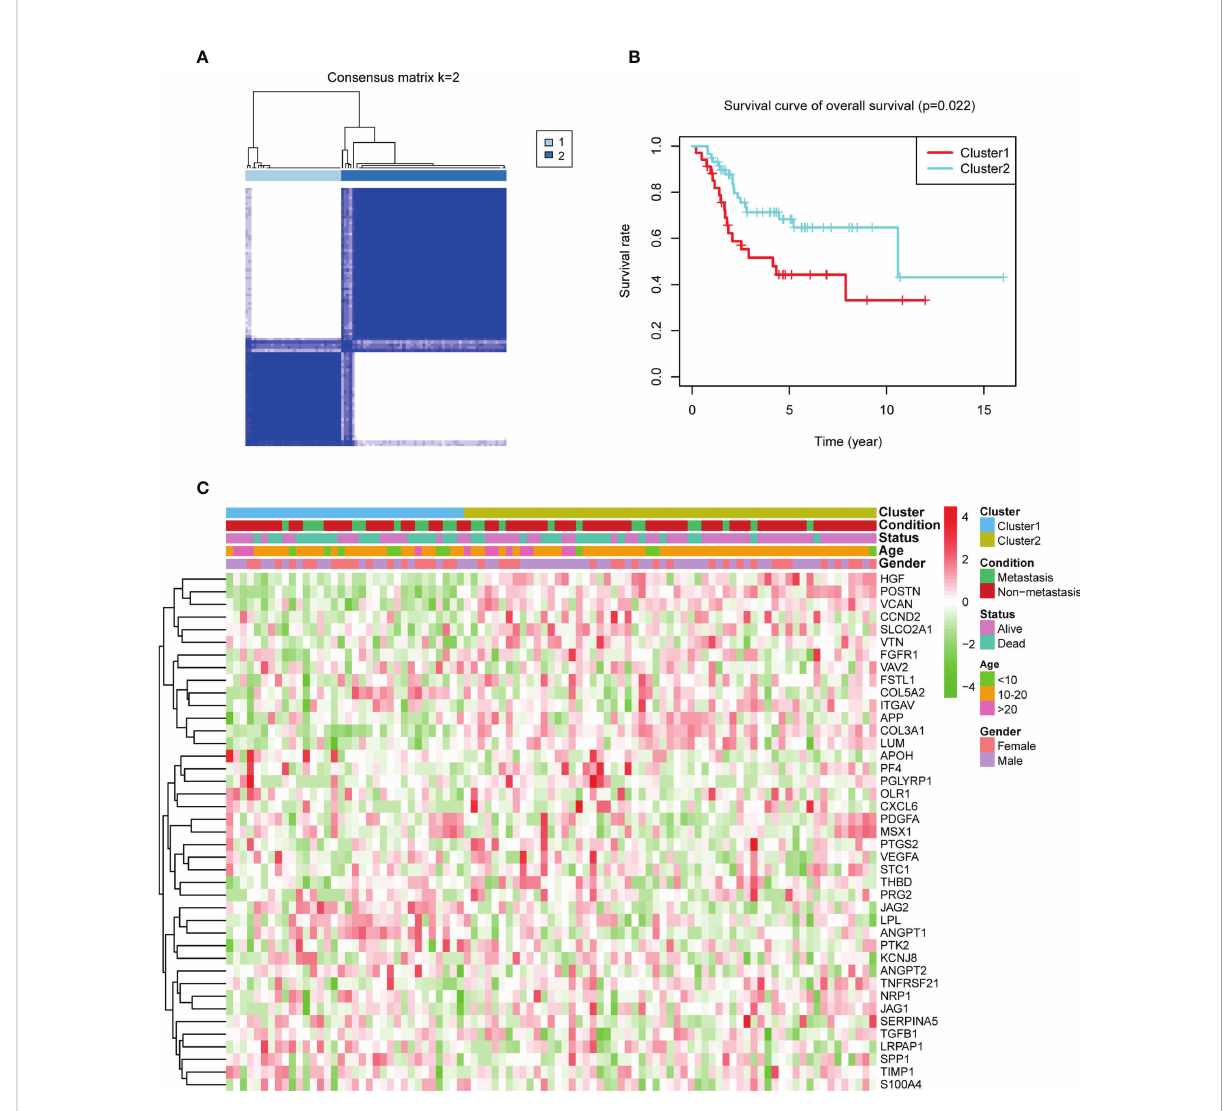
FIGURE 1 Consensus clustering by angiogenesis-related genes (ARGs) and their expression in the two angiogenesis subgroups. (A) The consensus matrix heatmap showed that k = 2 can divide samples into two subgroups well. (B) Kaplan – Meier plots comparing the overall survival between the two subgroups (log-rank p- value = 0.022). (C) A heatmap about the expression of ARGs and clinical features in the two subgroups. Green means low expression and red means high